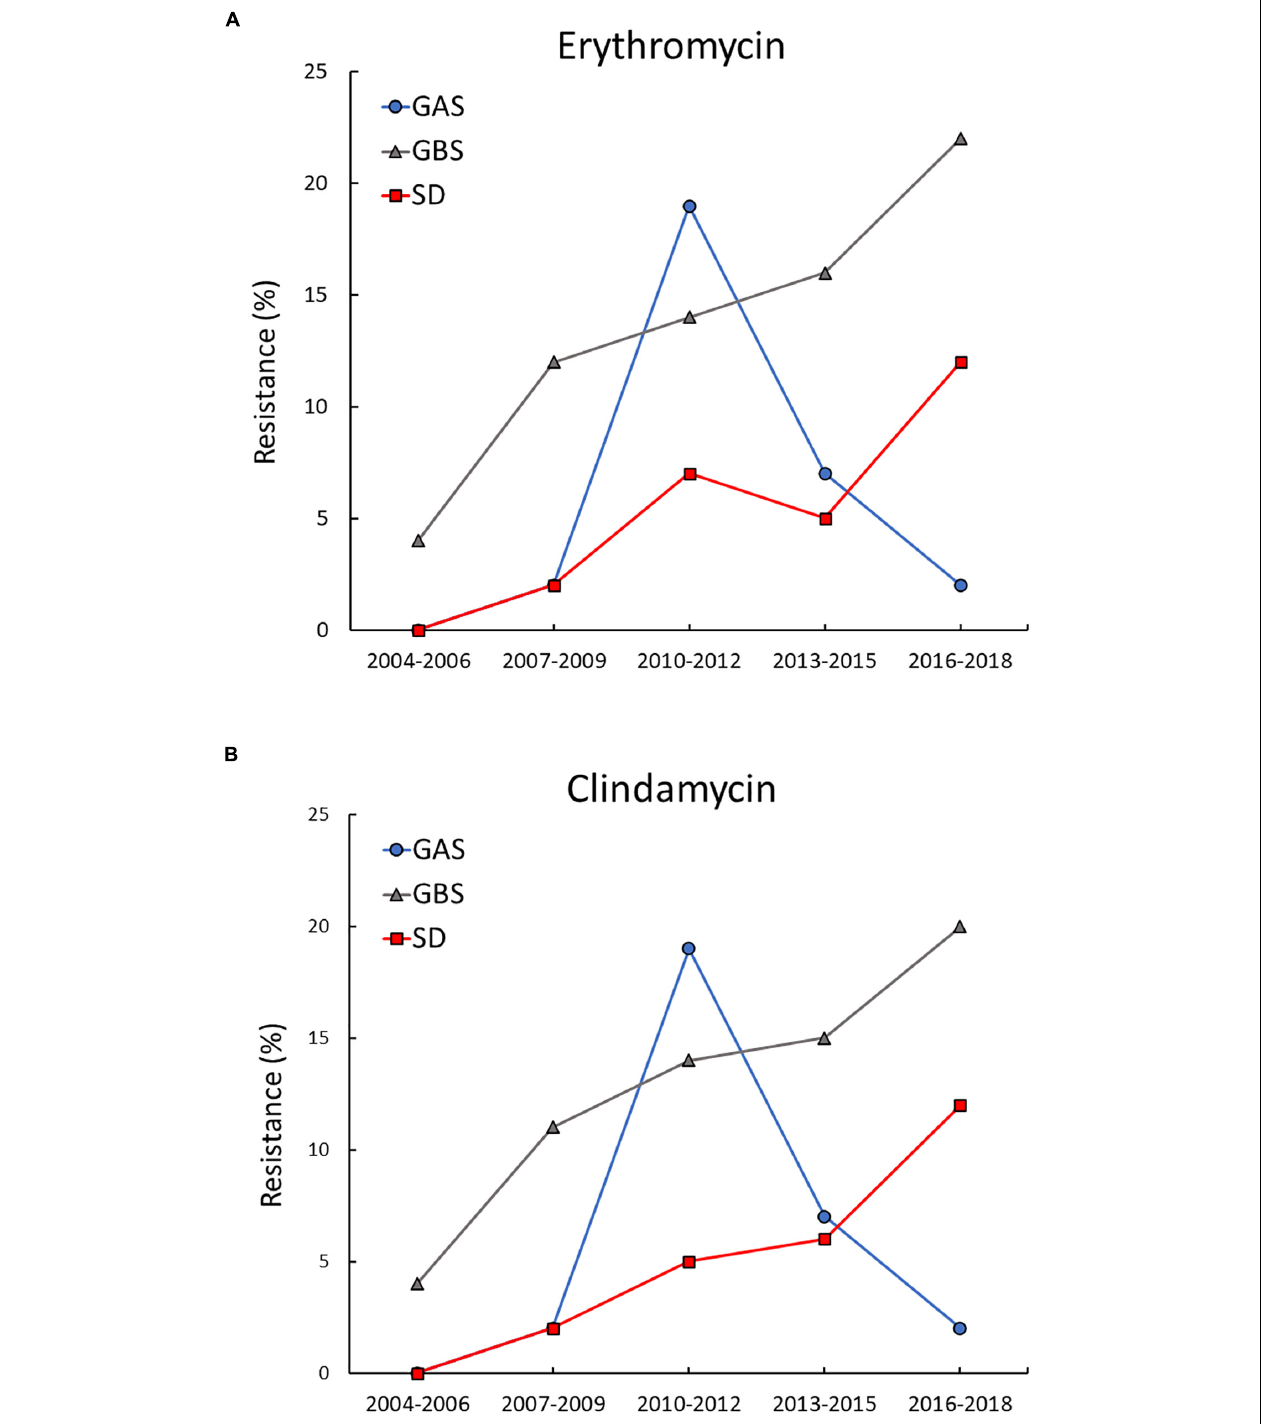
FIGURE 1 | Temporal trends of erythromycin and clindamycin resistance in BHS. Resistance to erythromycin (A) and clindamycin (B) increased significantly in Streptococcus agalactiae (GBS) and Streptococcus dysgalactiae (SD) during the study period. In Streptococcus pyogenes (GAS) resistance to erythromycin and clindamycin remained low, apart from a transient outbreak of resistance to both agents in the period 2010–2012.